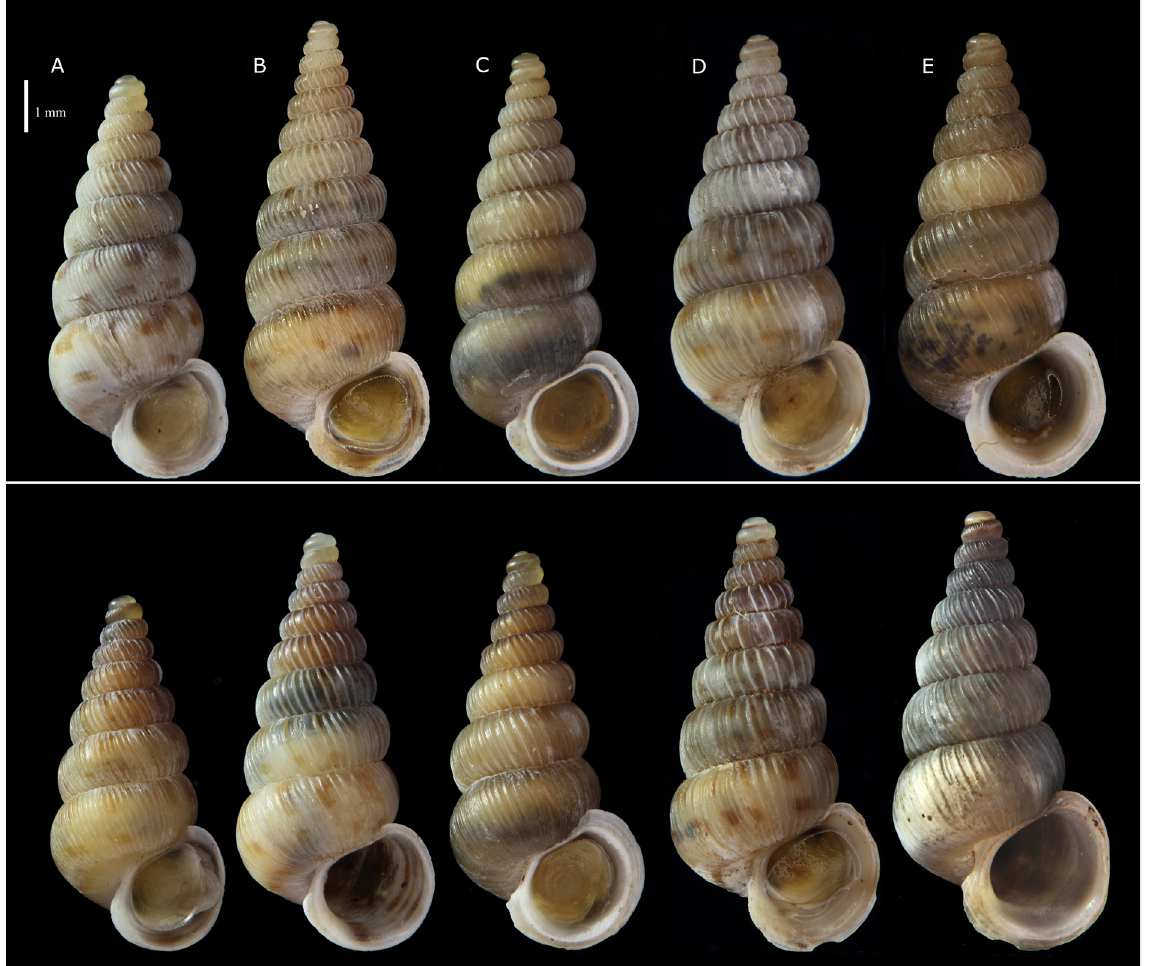
Fig. 14. The five species of Clessiniella Zallot et al ., 2015. A–D . Picture of a female (top) and male (bottom) specimen from the type localities. A . Cochlostoma ( Clessiniella ) anomphale Boeckel, 1939. Vellach, Austria (EZ0991). B . Co. ( Cl. ) stelucarum sp. nov., Cornino, Italy (EZ0104). C . Co. ( Cl. ) tergestinum (Westerlund, 1878), Val Rosandra, Italy (EZ0840). D . Co. ( Cl. ) villae (Strobel, 1851), Mizzole, Italy (EZ0878). E . Specimens from a locality close to the type one: Co. ( Cl. ) waldemari (A.J.Wagner, 1897), Mt Klek, Croatia